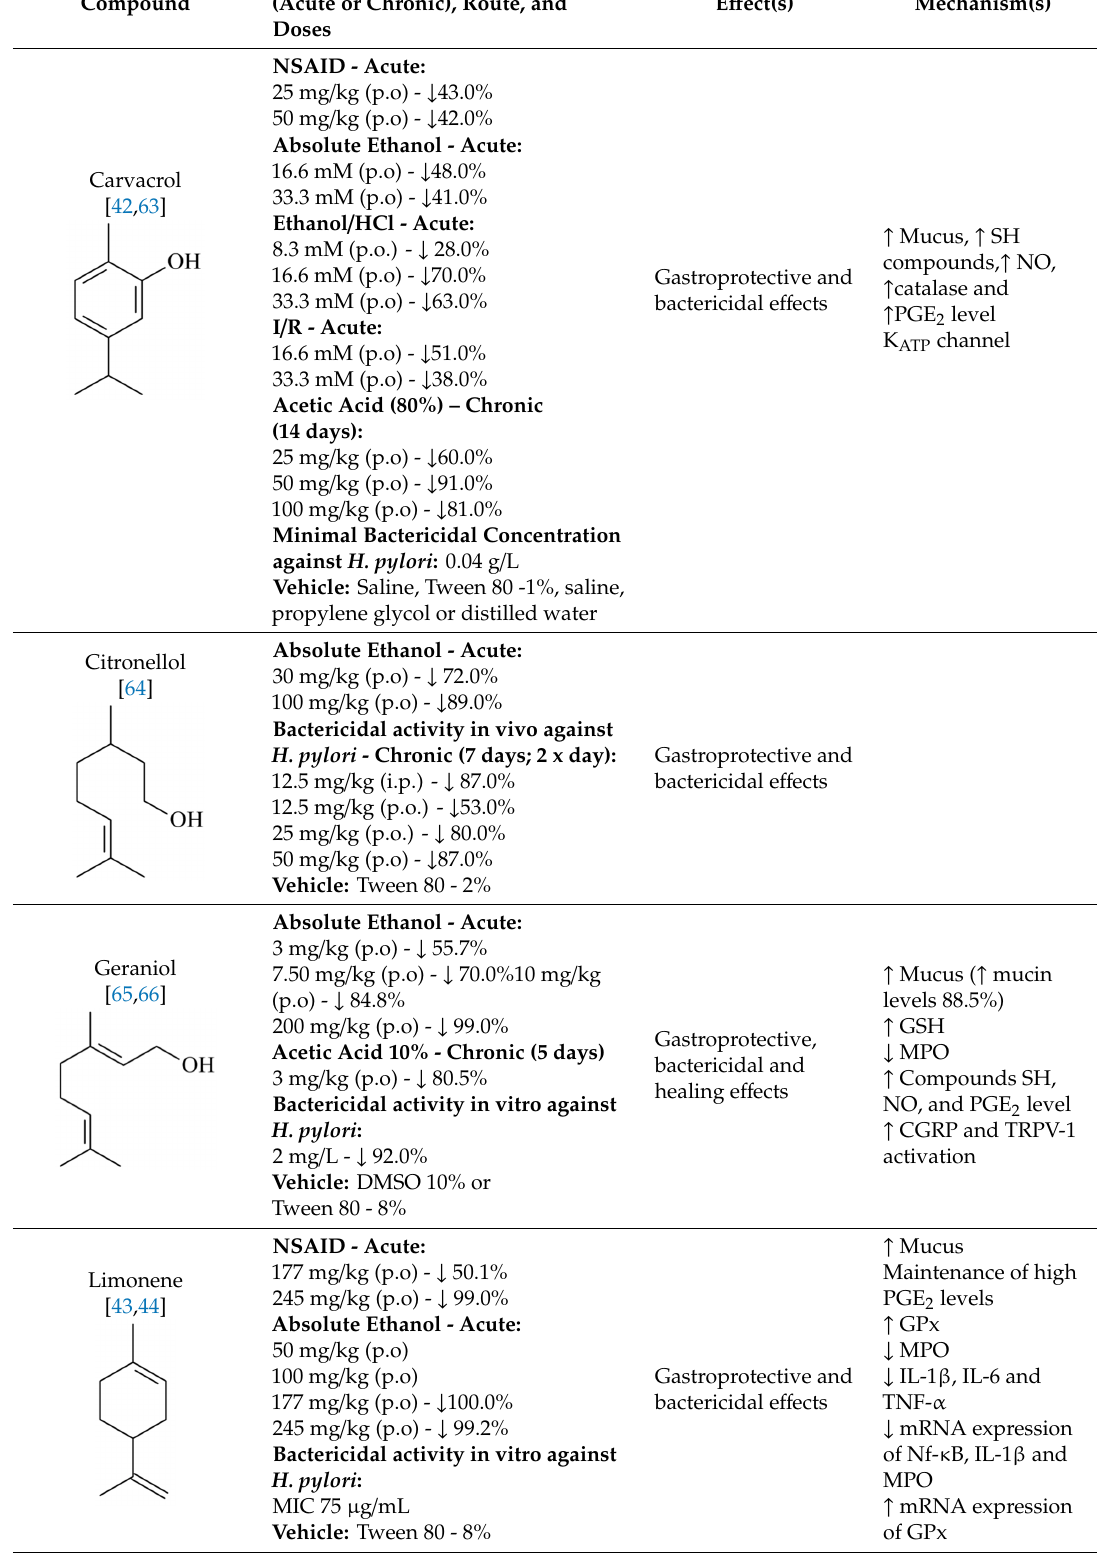
Table 2. Monoterpenes with anti- Helicobacter pylori activity.